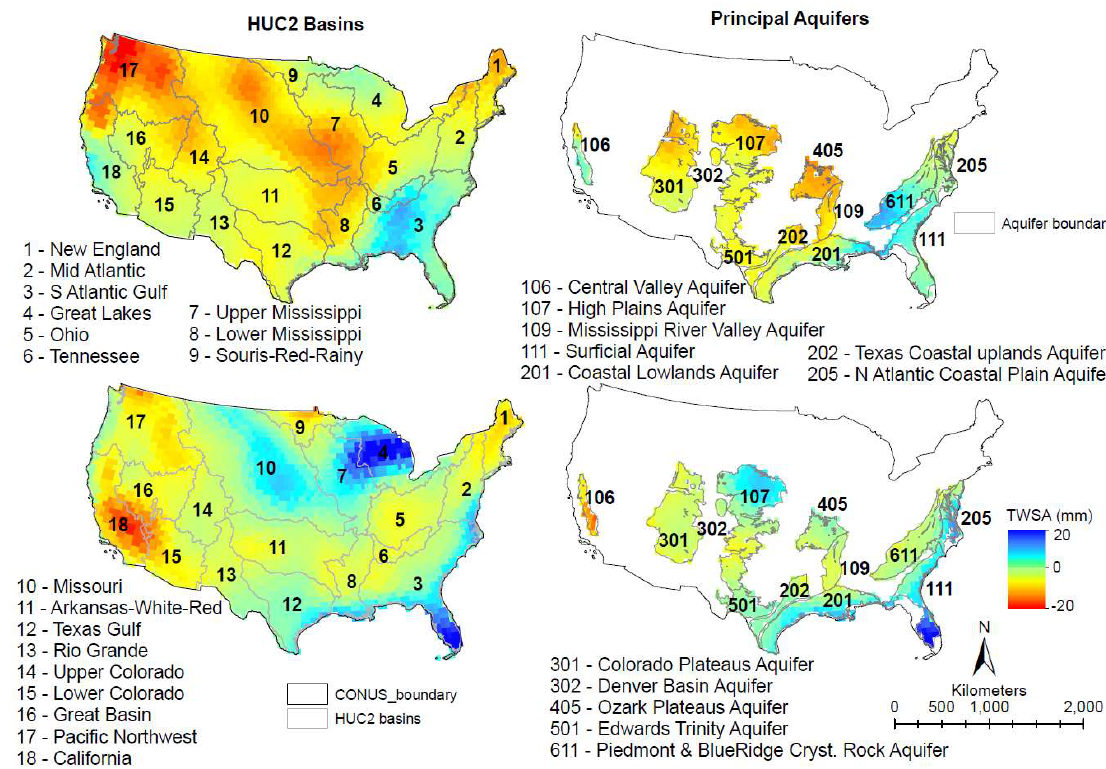
Figure 1. Study area regions. Hydrologic Unit Code 2 (HUC2) surface basin boundaries (left) and principal aquifer boundaries (right). The background map shows Gravity Recovery and Climate Experiment (GRACE)-derived total water storage anomaly (TWSA) for August 2003 (top) and August 2016 (bottom) in mm per month summarized for previously defined HUC2 surface basins and principal aquifers.